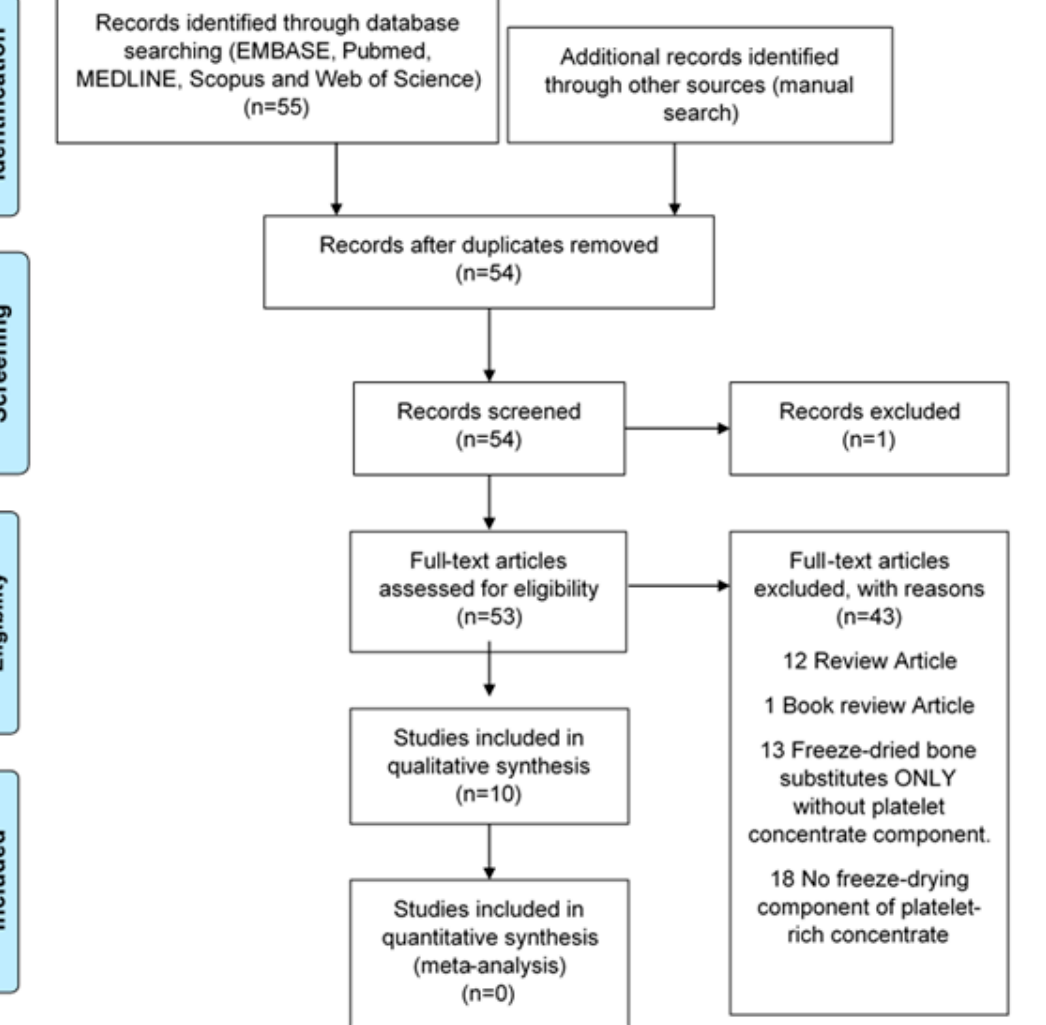
Figure 3. Flowchart of manuscript screening process and inclusion in the review.